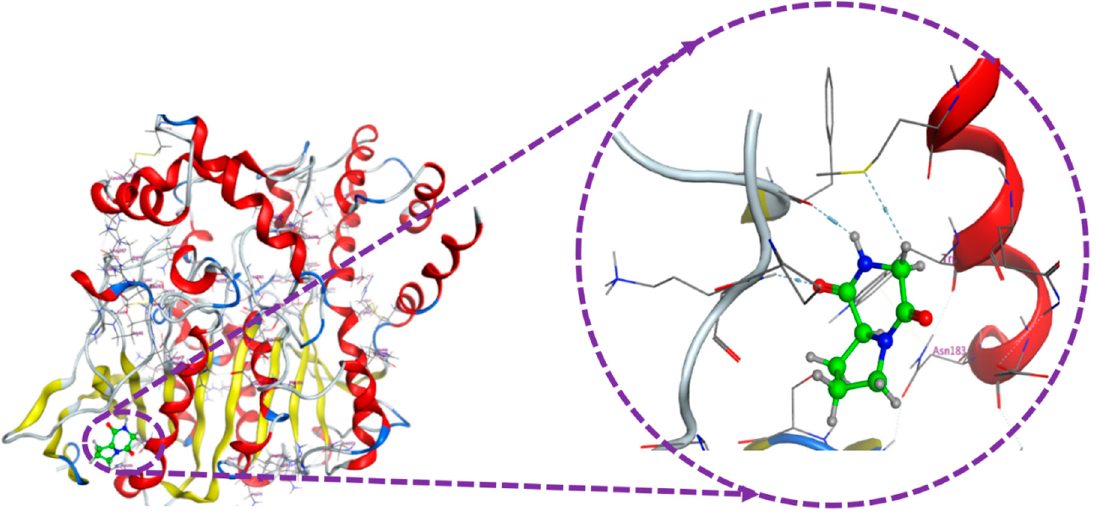
Figure 5. Interaction of hexahydropyrrolo [1,2-a] pyrazine-1,4-dione with enzyme acetylcholinesterase-targeting antinematode effects at the active site.